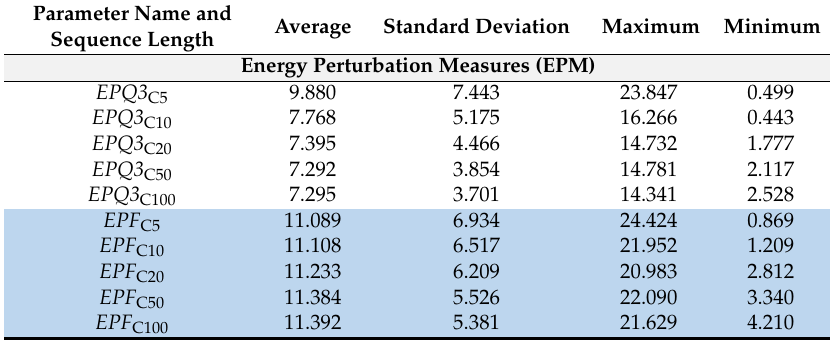
Table A3. Group values of all parameters for Energy Perturbation Measures